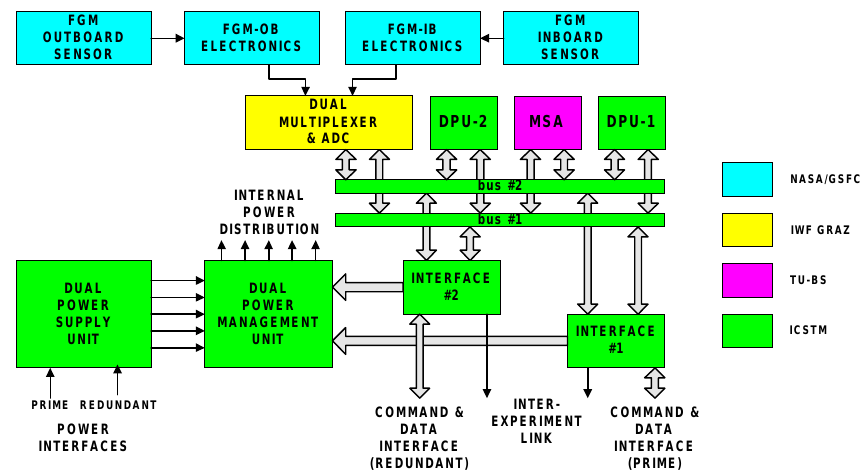
Fig. 1. Block diagram of the FGM instrument on